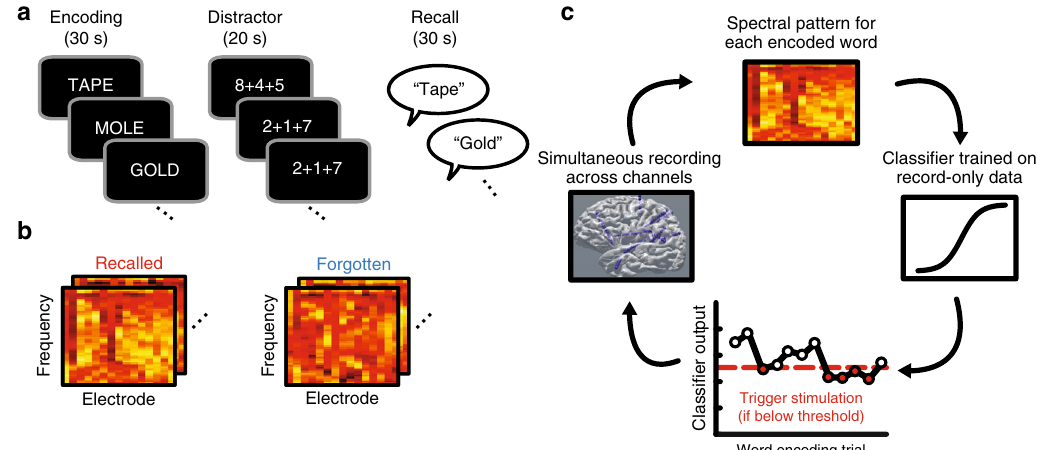
Fig. 1 Closed-loop approach. a For each list of the free recall task, subjects encoded 12 nouns presented sequentially, followed by an arithmetic distractor and the verbal recall phase. Subjects performed at least three sessions of record-only free recall. b After the record-only sessions, we use spectral decomposition to measure power at a set of frequencies ranging from 3 to 180 Hz for each encoded word. We used the patterns of spectral power across electrodes to train a penalized logistic regression classi fi er to discriminate encoding activity during subsequently recalled words from subsequently forgotten words. c In later closed-loop sessions, we applied spectral decomposition to each word encoding period while subjects performed the task. This produced a set of frequency × electrode features to which we applied the classi fi er trained on the record-only data. If the resulting estimated probability of recall was below 0.5, we triggered 500 ms of stimulation to either the lateral temporal cortex or a control